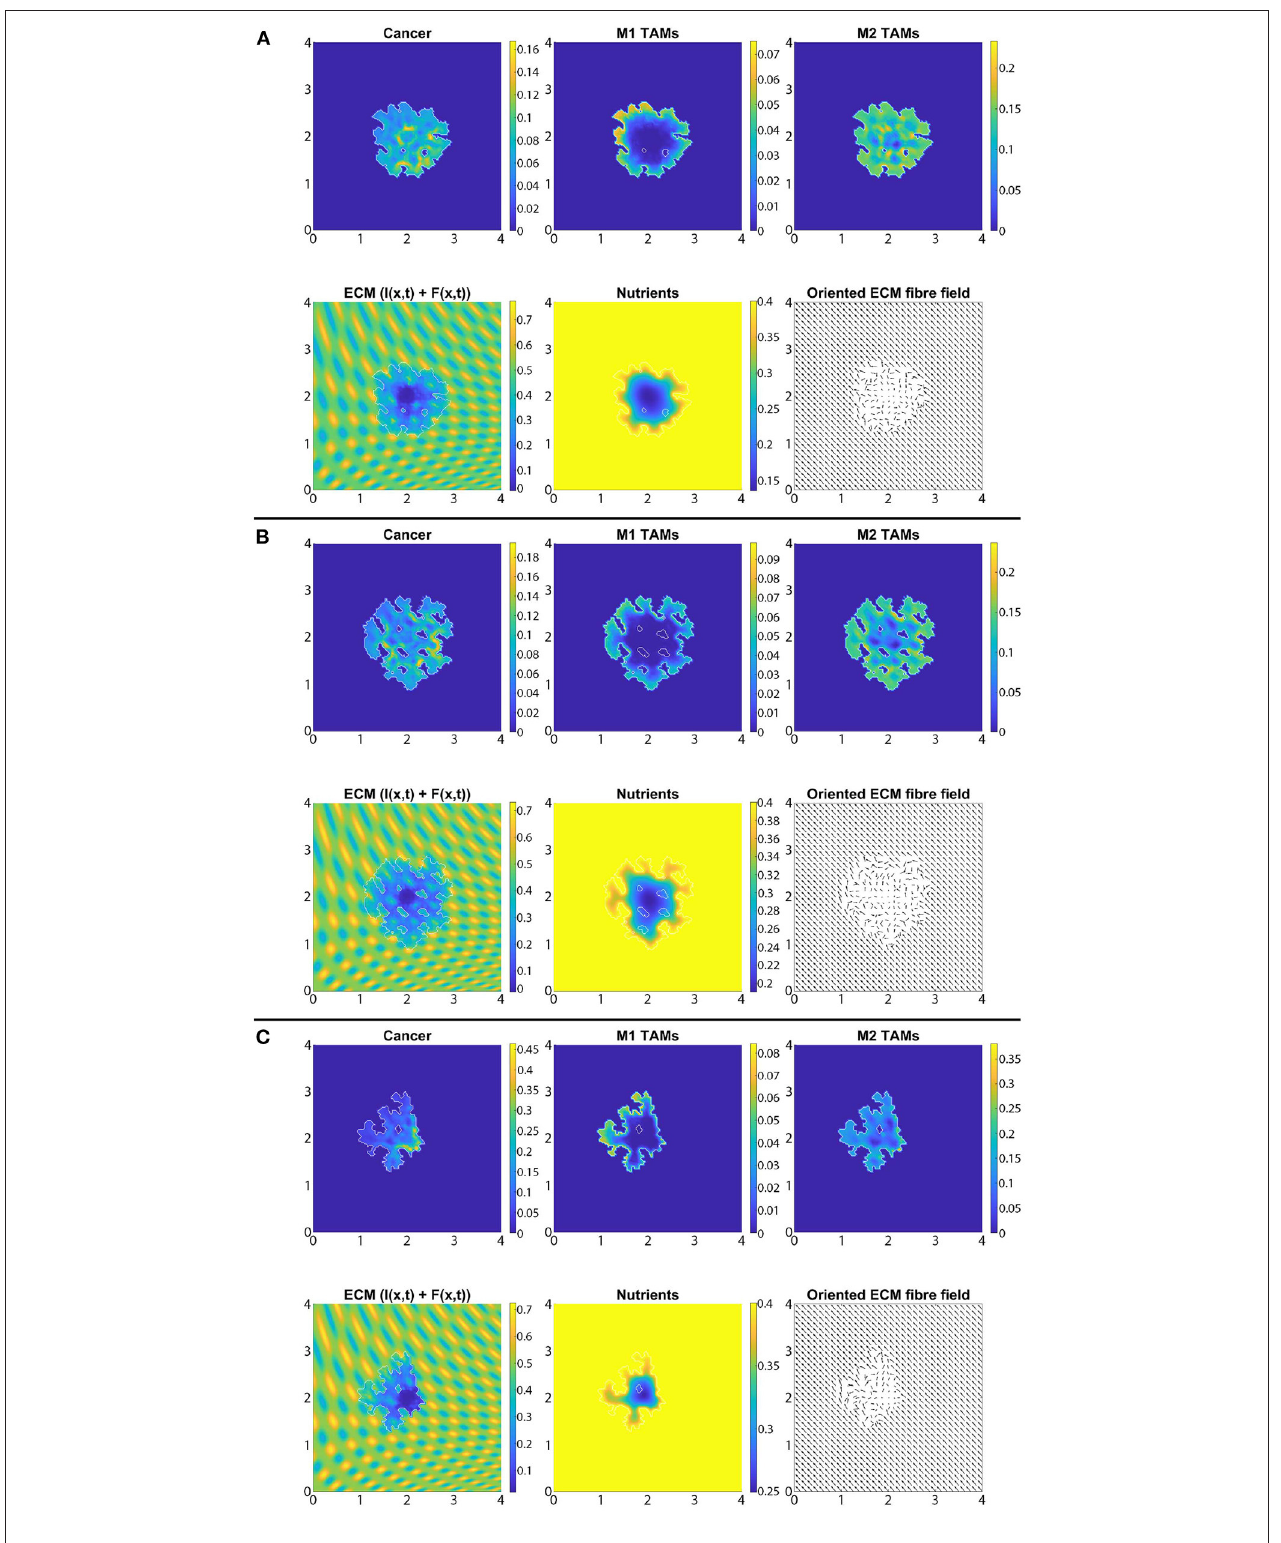
FIGURE 7 | Baseline simulation with no macrophage re-polarisation (i.e., we set R p = 0) at final time 50 1 t . (A) β = 0.75, (B) β = 0.7875, and (C) β = 0.825.